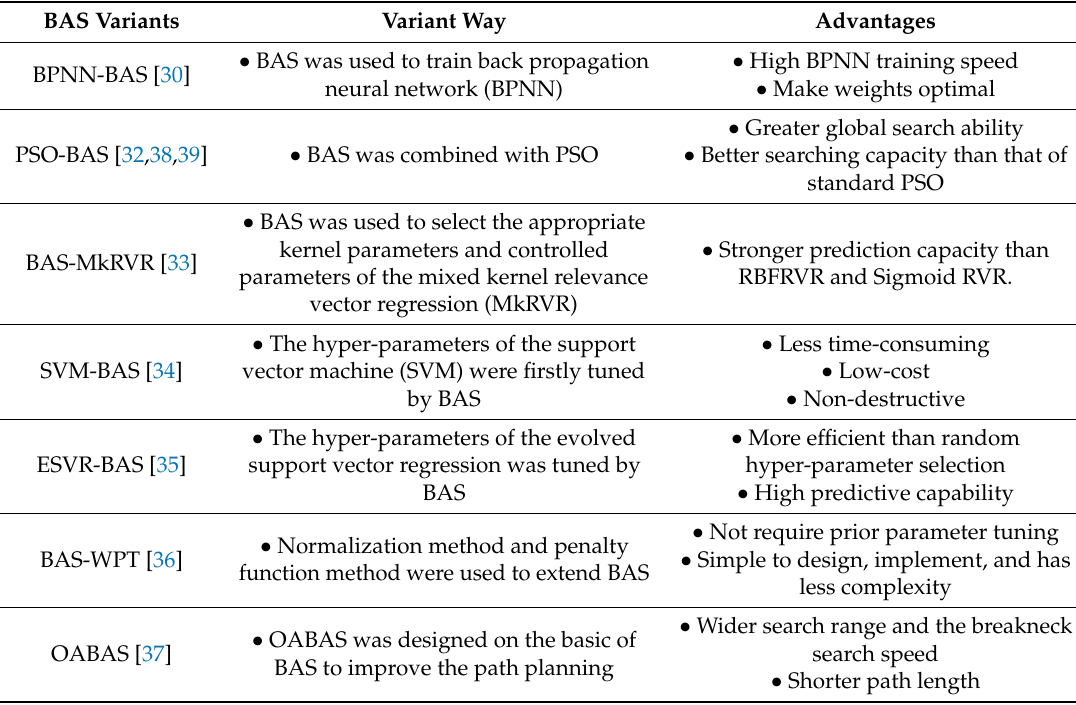
Table 1. Variant ways and advantages of BAS variants.